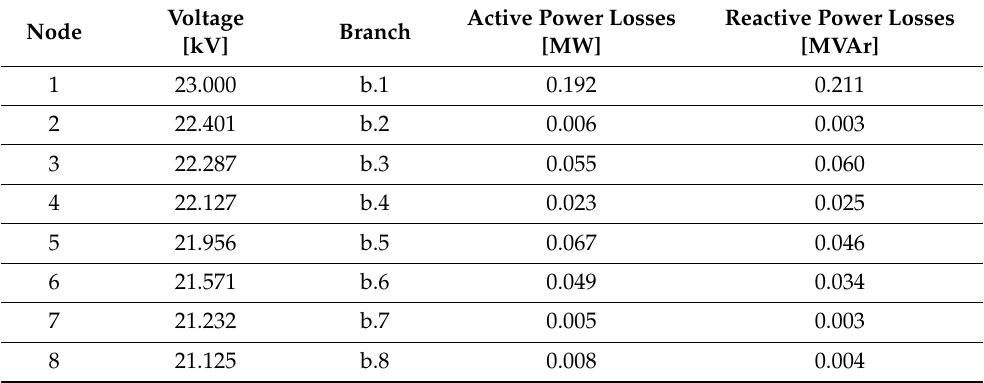
Table 5. Results of the steady-state solution using the enumerative method after optimization calculation.